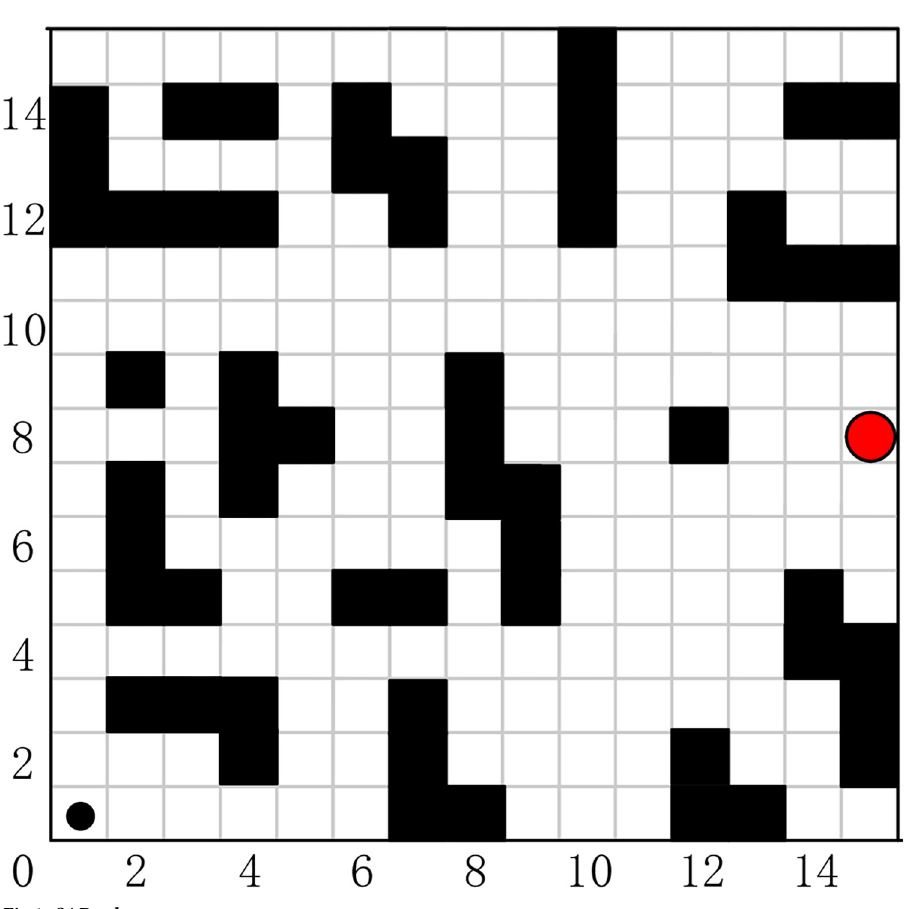
Fig 1. SAR robot movement